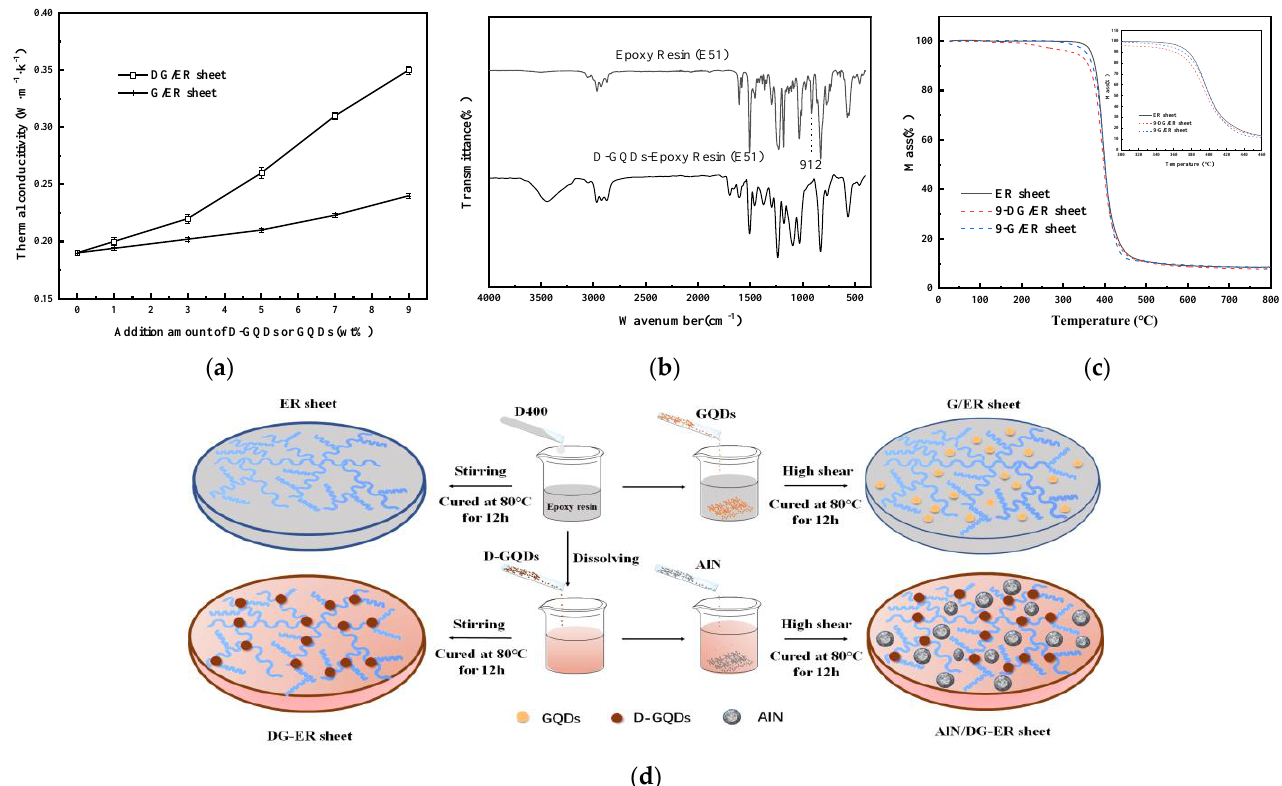
Figure 3. ( a ) The thermal conductivity of the DG-ER and G/ER sheets; ( b ) the FT − IR spectra of epoxy − resin (E-51) and D-GQDs–epoxy–resin (E-51) sheet; ( c ) the TGA curves of ER sheet, 9-DG-ER sheet and 9-G/ER sheet (inset: an enlarged view of the curves); ( d ) schematic representations of the conductive